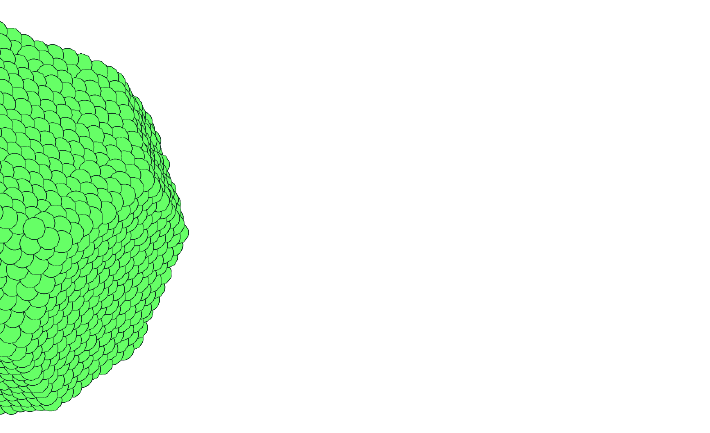
Figure 1. Initial nanoparticle structure. The nanoparticles were initially truncated polyhedrons with small random fluctuation in the atomic positions.